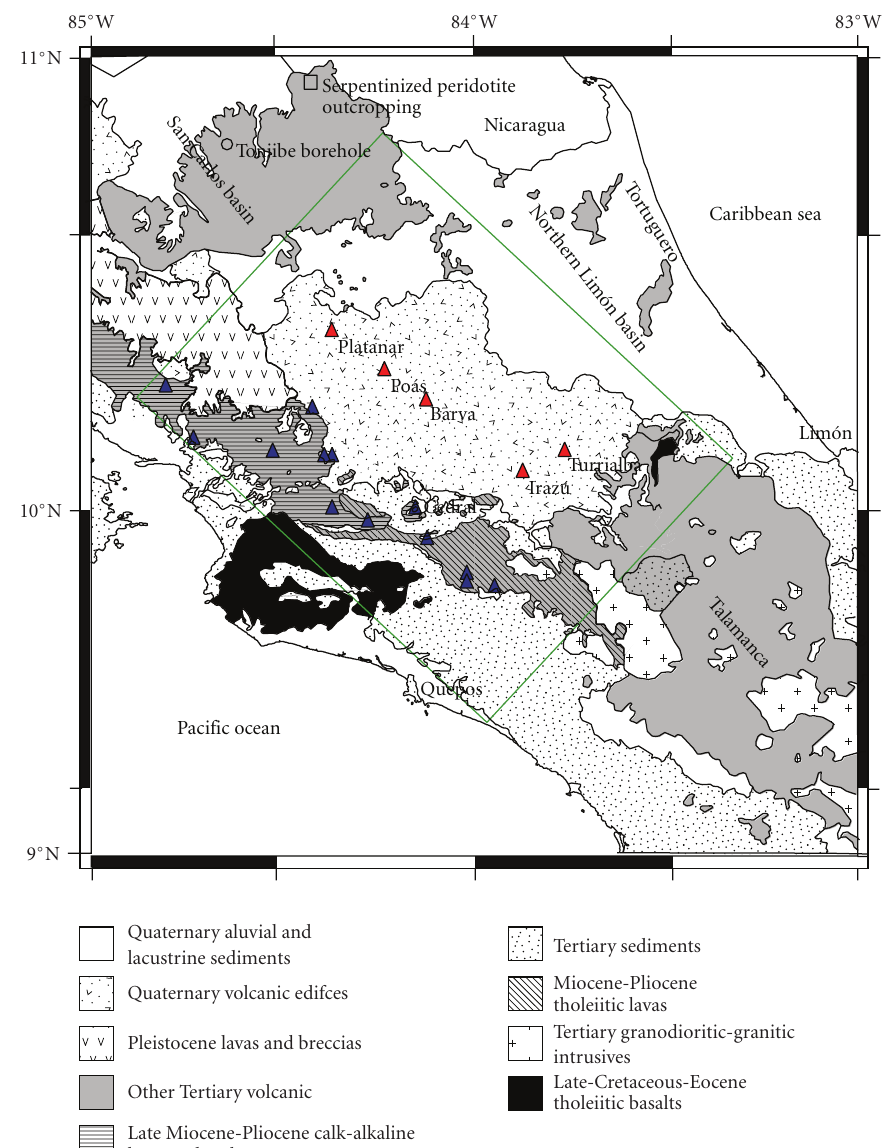
Figure 3: Simplified surface geology of the study area based on cartography by Tournon and Alvarado [9] and Denyer and Alvarado [10]. The green box shows the extent of the modeled area. Red triangles show the locations of main Quaternary volcanic vents. Blue triangles show the locations of paleo-volcanic vents for the Neogene “Aguacate” volcanic paleo-arc, inferred from surface geology and